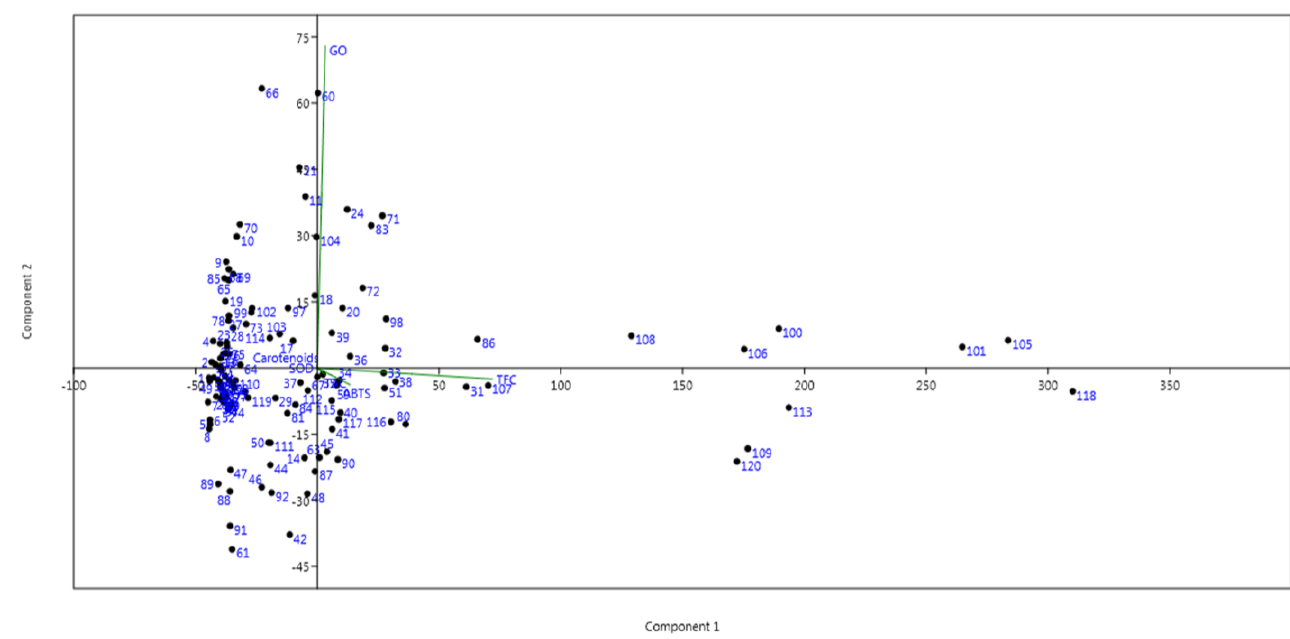
Figure 3. Genotype-by-trait biplot diagram showing 120 germplasm lines in two PCs for 6 antioxidant traits.